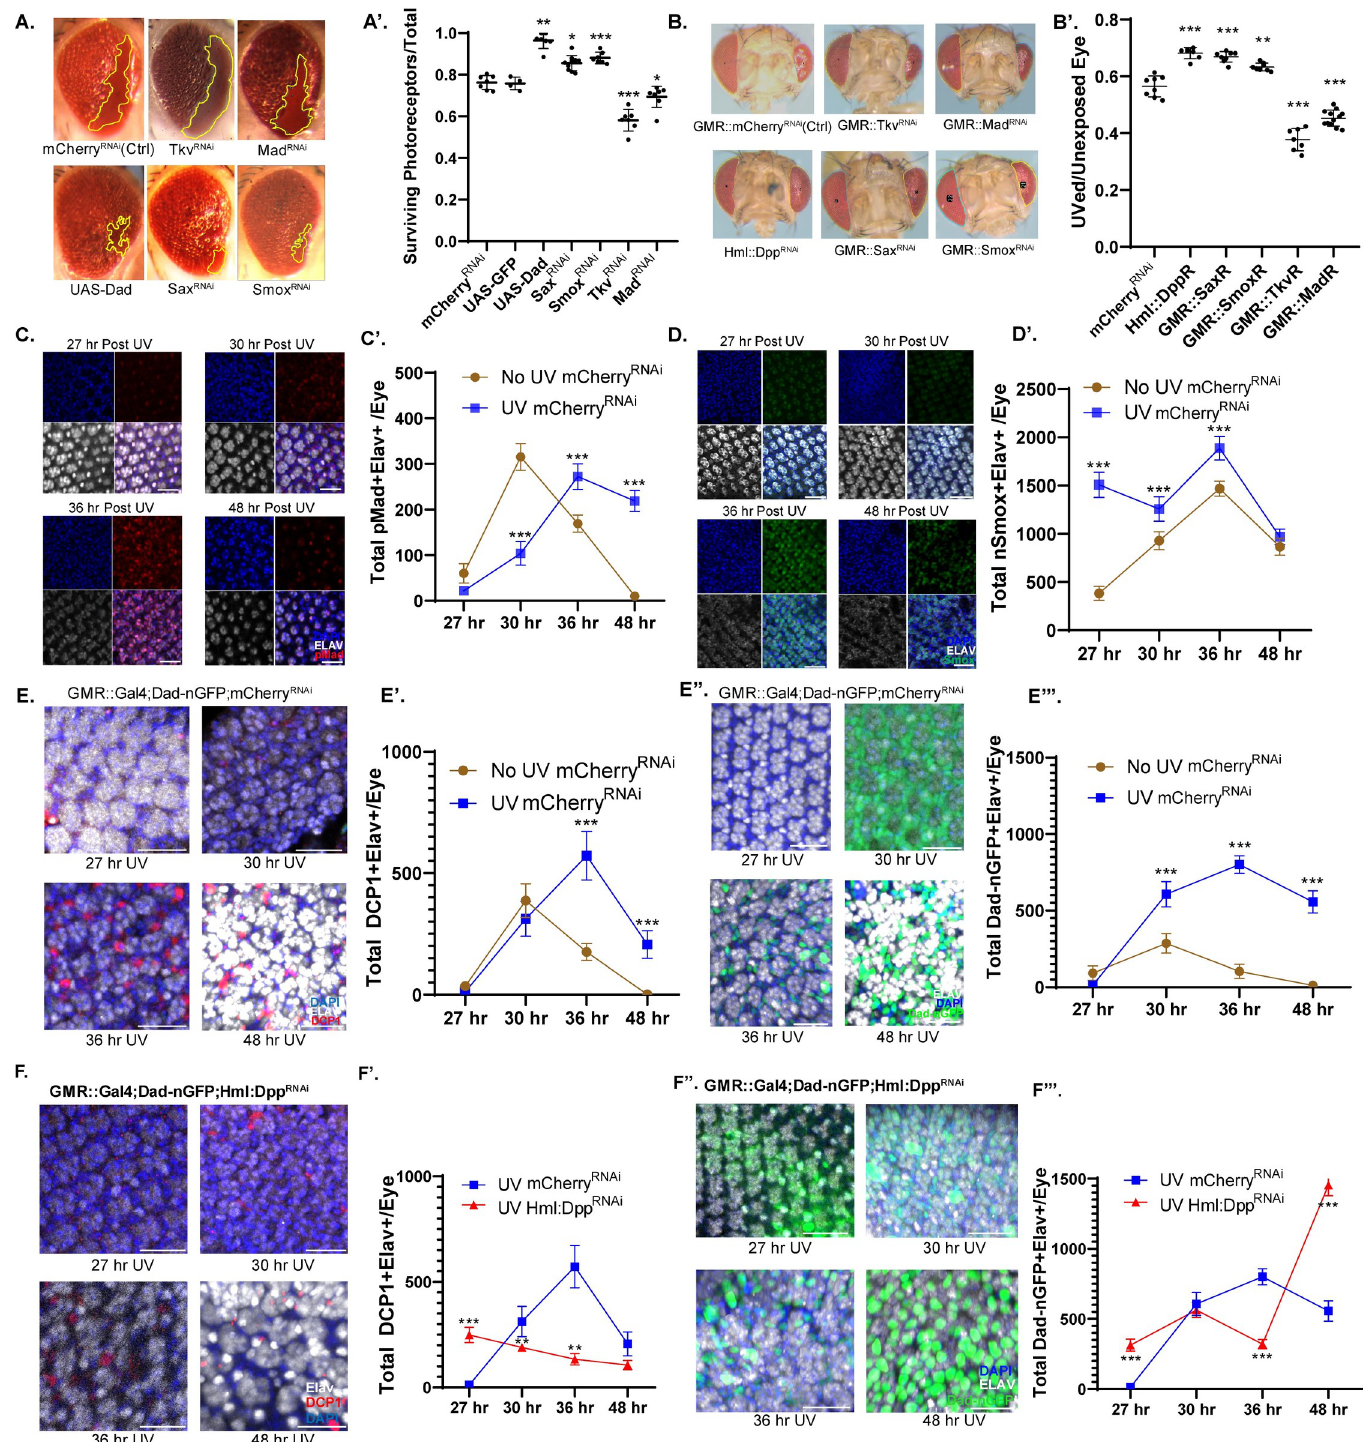
Fig 1. Dpp inhibition controls JNK and UV driven apoptosis in Drosophila. (1A-A’) Representative images and quantitation of ratio of surviving photoreceptors to total in w;Sep::Gal4,UAS::HepACT flies crossed with RNAi lines of each genotype. Representative images and quantification of adult GMR::Gal4; /UAS::RNAi progeny following knockdown of is compared through ratio of UV-exposed to unexposed eye (1B-B’). Representative images and quantitation of the pMad (in maturing GMR:: Gal4;Dad-nGFP/UAS::RNAi) and nuclear Smox (in GMR::Gal4;Smox::FLAG::GFP/UAS::RNAi) (1D-D’) expression in Elav+ (1C-C’) progeny eye with and without irradiation at 27, 30, 36 and 48hours post UV. Representative images and quantitation of total DCP1+ Elav+ cells (1E-E’) or DadnGFP+/Elav+ cells (1 E”-F’”) in GMR::